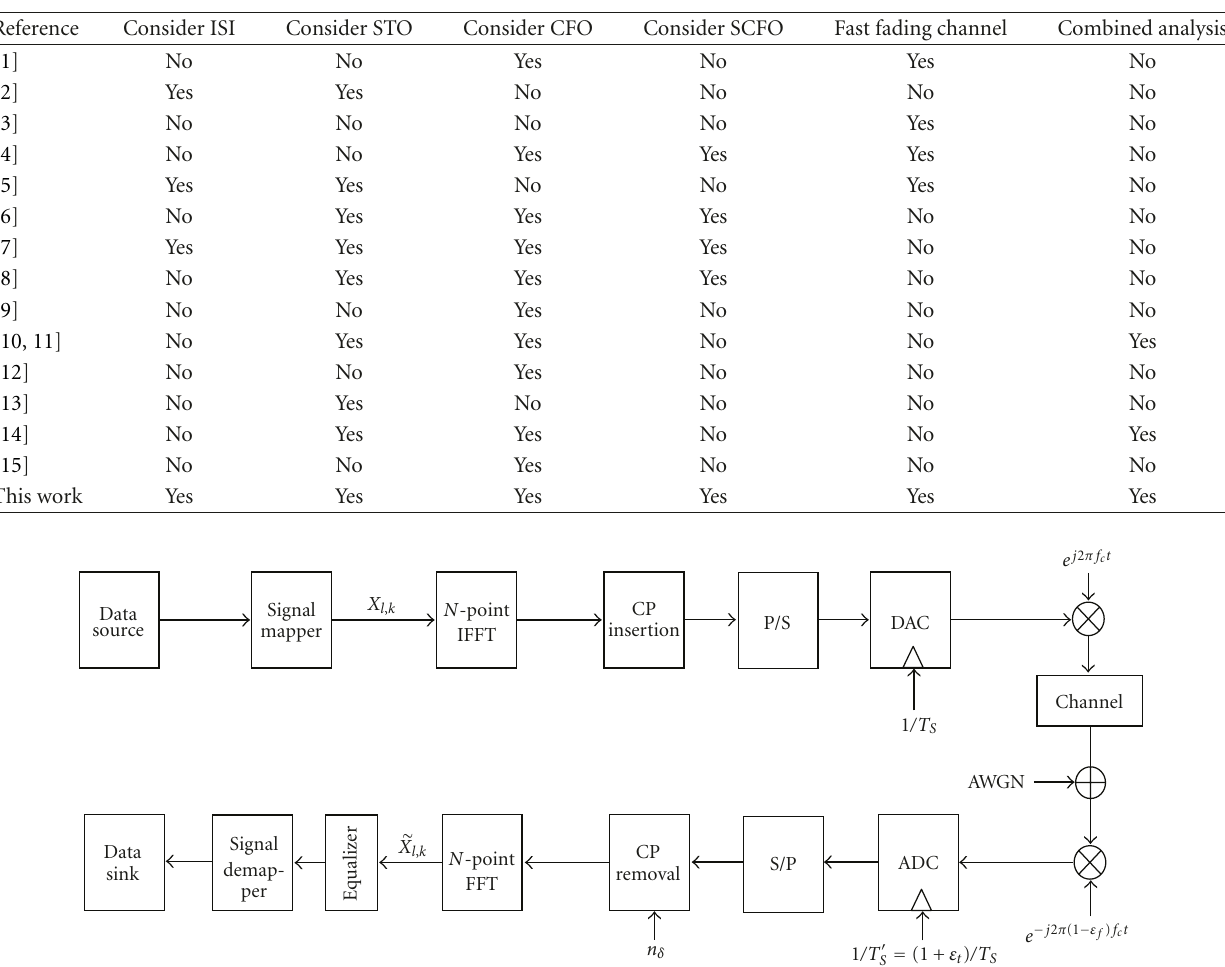
Table 1: Comparison of synchronization errors analyses.